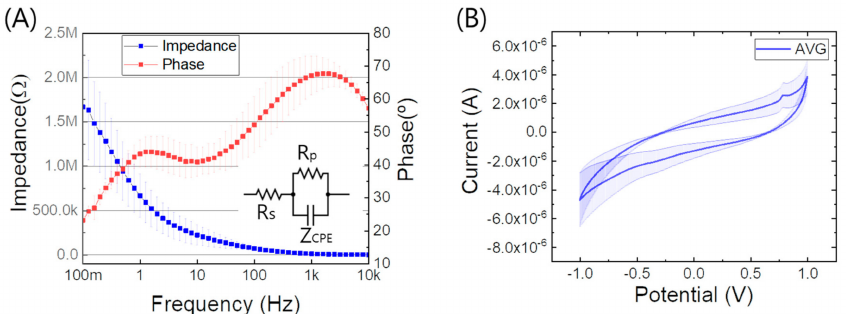
Figure 2. Electrochemical impedance spectroscopy (EIS) and cyclic voltammetry (CV) measurements. ( A ) Bode magnitude and phase plots for the fabricated Parylene C-based microelectrodes; (inset) equivalent circuit model used for electrode characterization. ( B ) CV results of the microelectrode array.